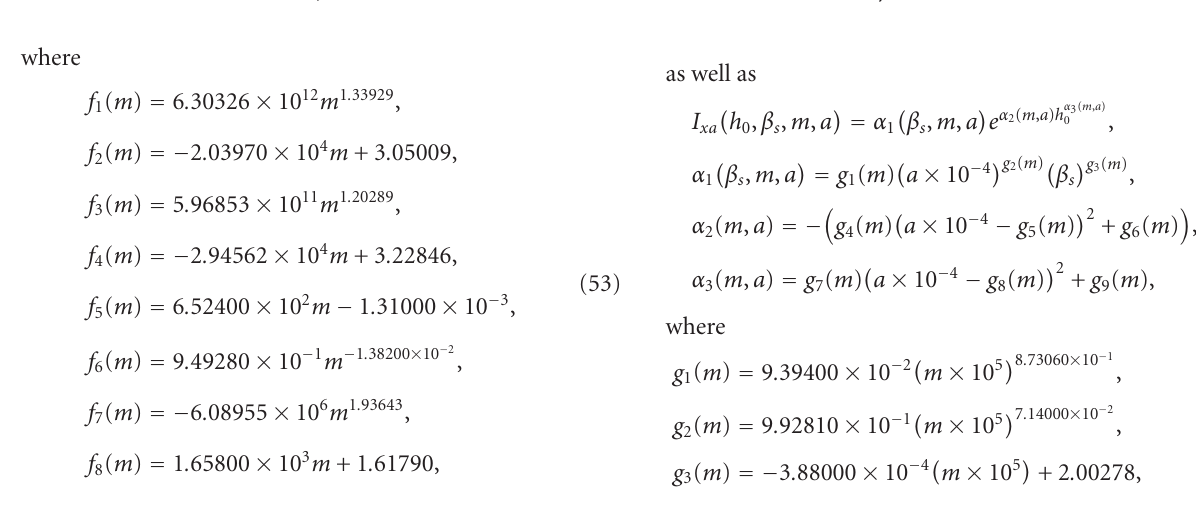
Figure 17: I x ( h 0 , m ) for β s = 500 and a = 150000.